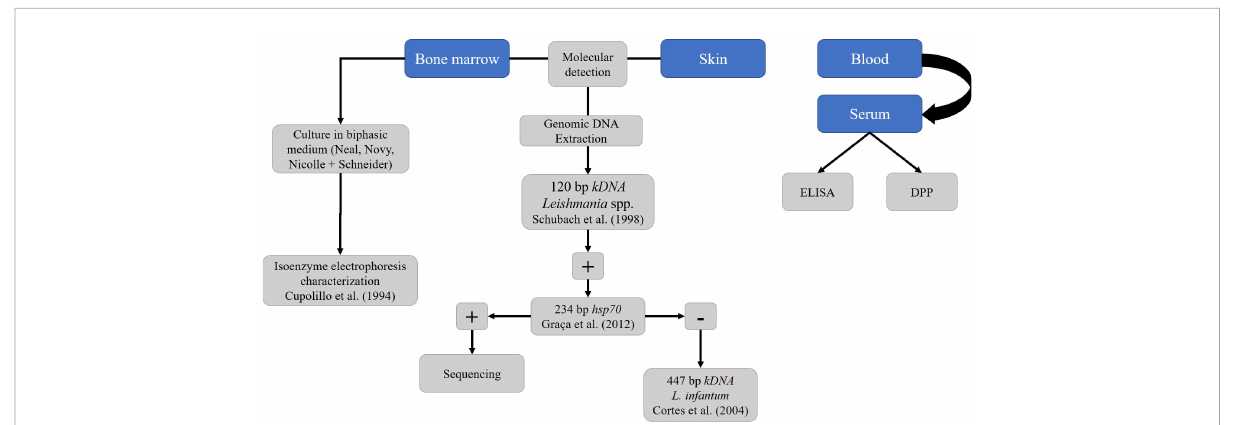
FIGURE 3 Diagnostic strategy for detection of Leishmania infantum in South American coatis ( Nasua nasua ) from forest fragments of Campo Grande, Mato Grosso do Sul, Midwest